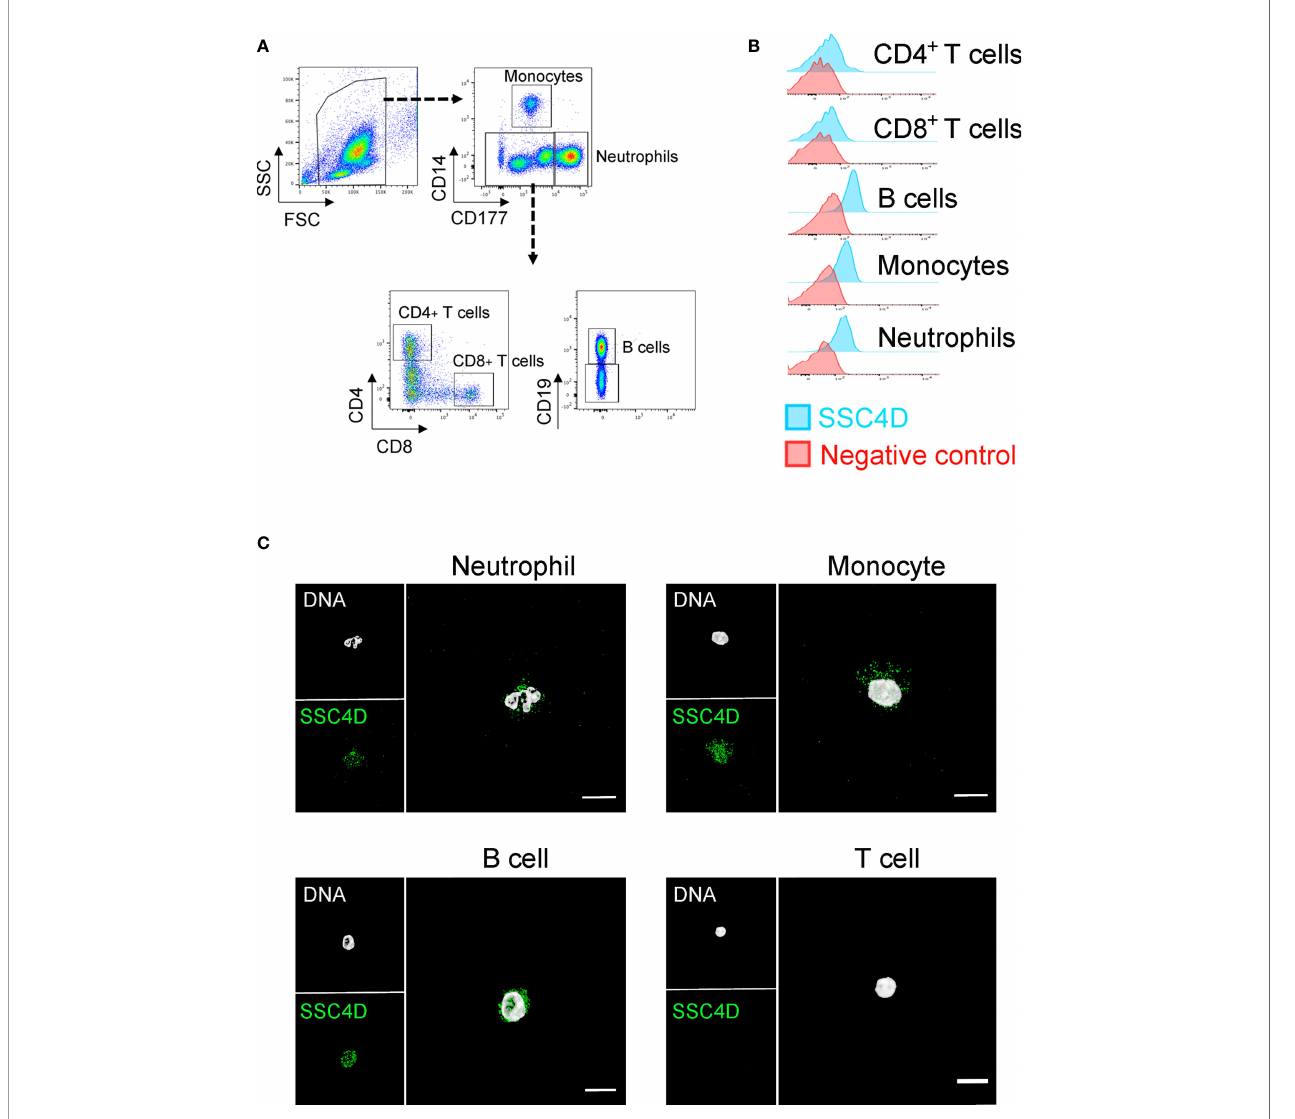
FIGURE 3 | SSC4D expression in human leukocytes. (A) Flow cytometry gating strategy for the identi fi cation of monocytes, neutrophils, B cells, and CD4 + and CD8 + T cells from human blood. (B) Intracellular labeling of SSC4D in different human cell populations, visualized by fl ow cytometry. In the control samples, the anti-SSC4D antibody was omitted. Representative results shown are from one of four independent experiments. (C) Representative single-cell images of FACS-sorted leukocytes, immunostained for SSC4D (green) and visualized by immuno fl uorescence (IF). White indicates DAPI staining. Representative results shown are from one of three independent experiments using different